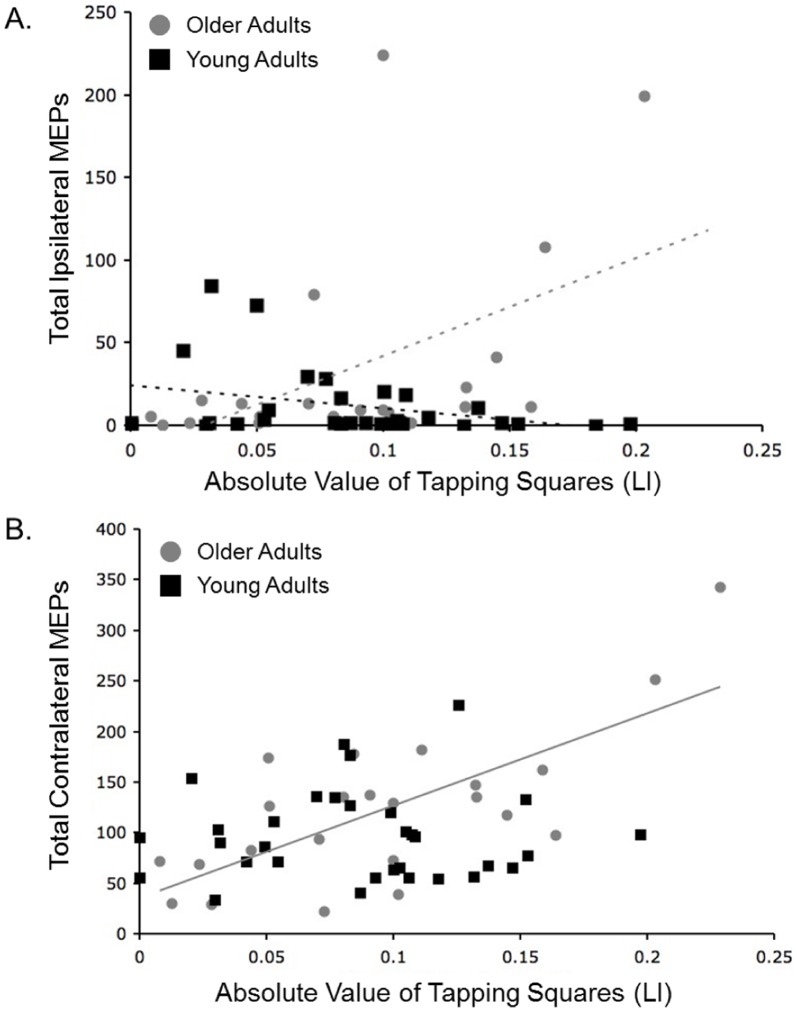
A. Ipsilateral MEPs and Handedness.Total number of ipsilateral MEPs plotted as a function of degree of handedness as measured by the absolute value of the tapping squares measure for the older (gray) and young (black) adults. The Poisson regression models indicate statistically significant relationships for both age groups (older adults: chi-squared = 8.42, p<.01; young adults: chi-squared = 3.98, p<.05) though they are in opposite directions. Overlaid lines serve to highlight and differentiate the relationships. B. Contralateral MEPs and Handedness. Total number of contralateral MEPs plotted as a function of degree of handedness, as measured by the absolute value of the tapping squares measure for the older (gray) and young (black) adults. The Poisson regression models indicate a statistically significant relationship in the older adults (r(21) = .72, p<.001), though there is no relationship in the young adults (r(31) = .02, p>.8).